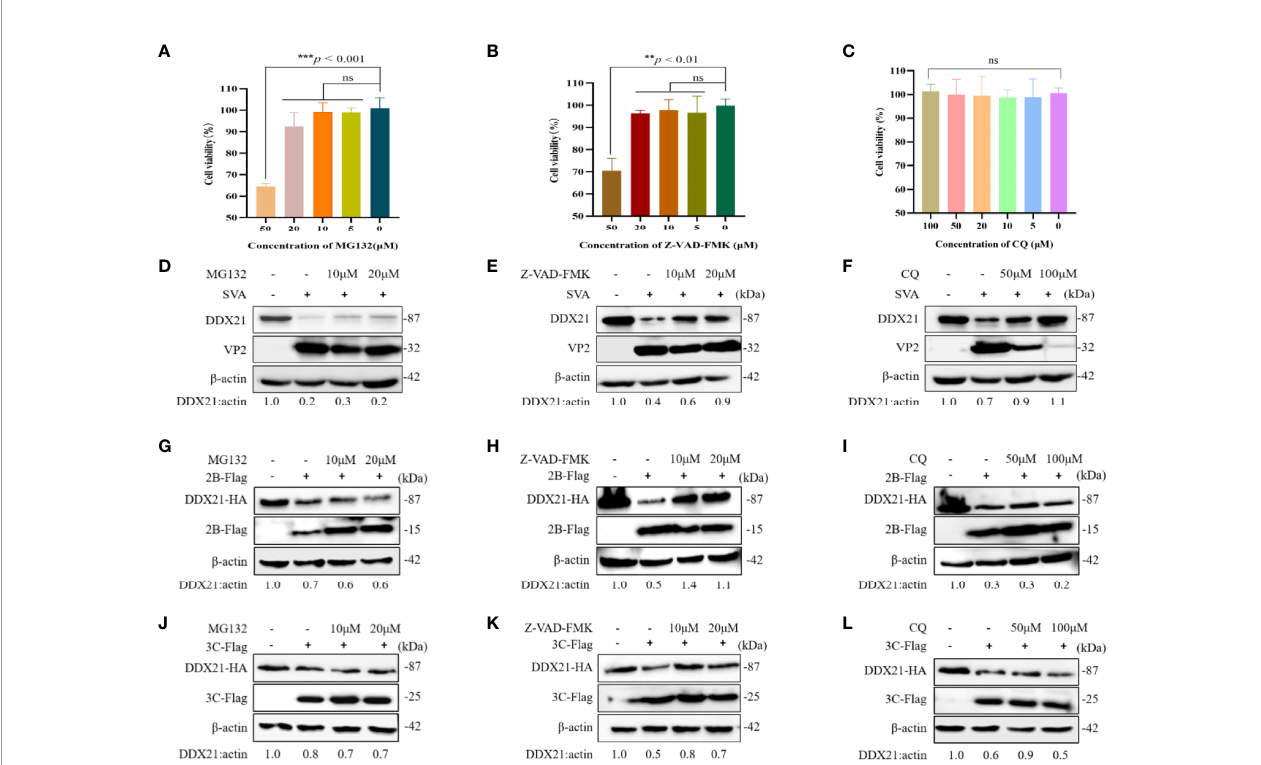
FIGURE 7 | DDX21 is degraded through the caspase pathway during SVA infection. Cells were treated with the indicated concentrations of inhibitors for 24 h. MTT method is used to detect BHK-21 cells cytotoxicity. (A) MG132. (B) Z-VAD-FMK. (C) CQ. (D – F) BHK-21 cells in six-well plates were incubated with different inhibitors and then infected with SVA at an MOI of 0.1. The cell lysates were analyzed by WB. MG132 was added at 10 to 20 µM, Z-VAD-FMK was added at 10 to 20 µM, and CQ was added at 50 to 100 µM. (G – I) BHK-21 cells were cotransfected with HA-DDX21 and 2B-Flag and then treated with different inhibitors. MG132 was added at 10 to 20 µM, Z-VAD-FMK was added at 10 to 20 µM, and CQ was added at 50 to 100 µM. The cell lysates were analyzed by WB. (J – L) BHK-21 cells were cotransfected with HA-DDX21 and 3C-Flag and then treated with different inhibitors. MG132 was added at 10 to 20 µM, Z-VAD-FMK was added at 10 to 20 µM, and CQ was added at 50 to 100 µM. The cell lysates were analyzed by WB. The statistical signi fi cance of differences was determined using a Student ’ s t -test (NS, not signi fi cant; ** p < 0.01; *** p <